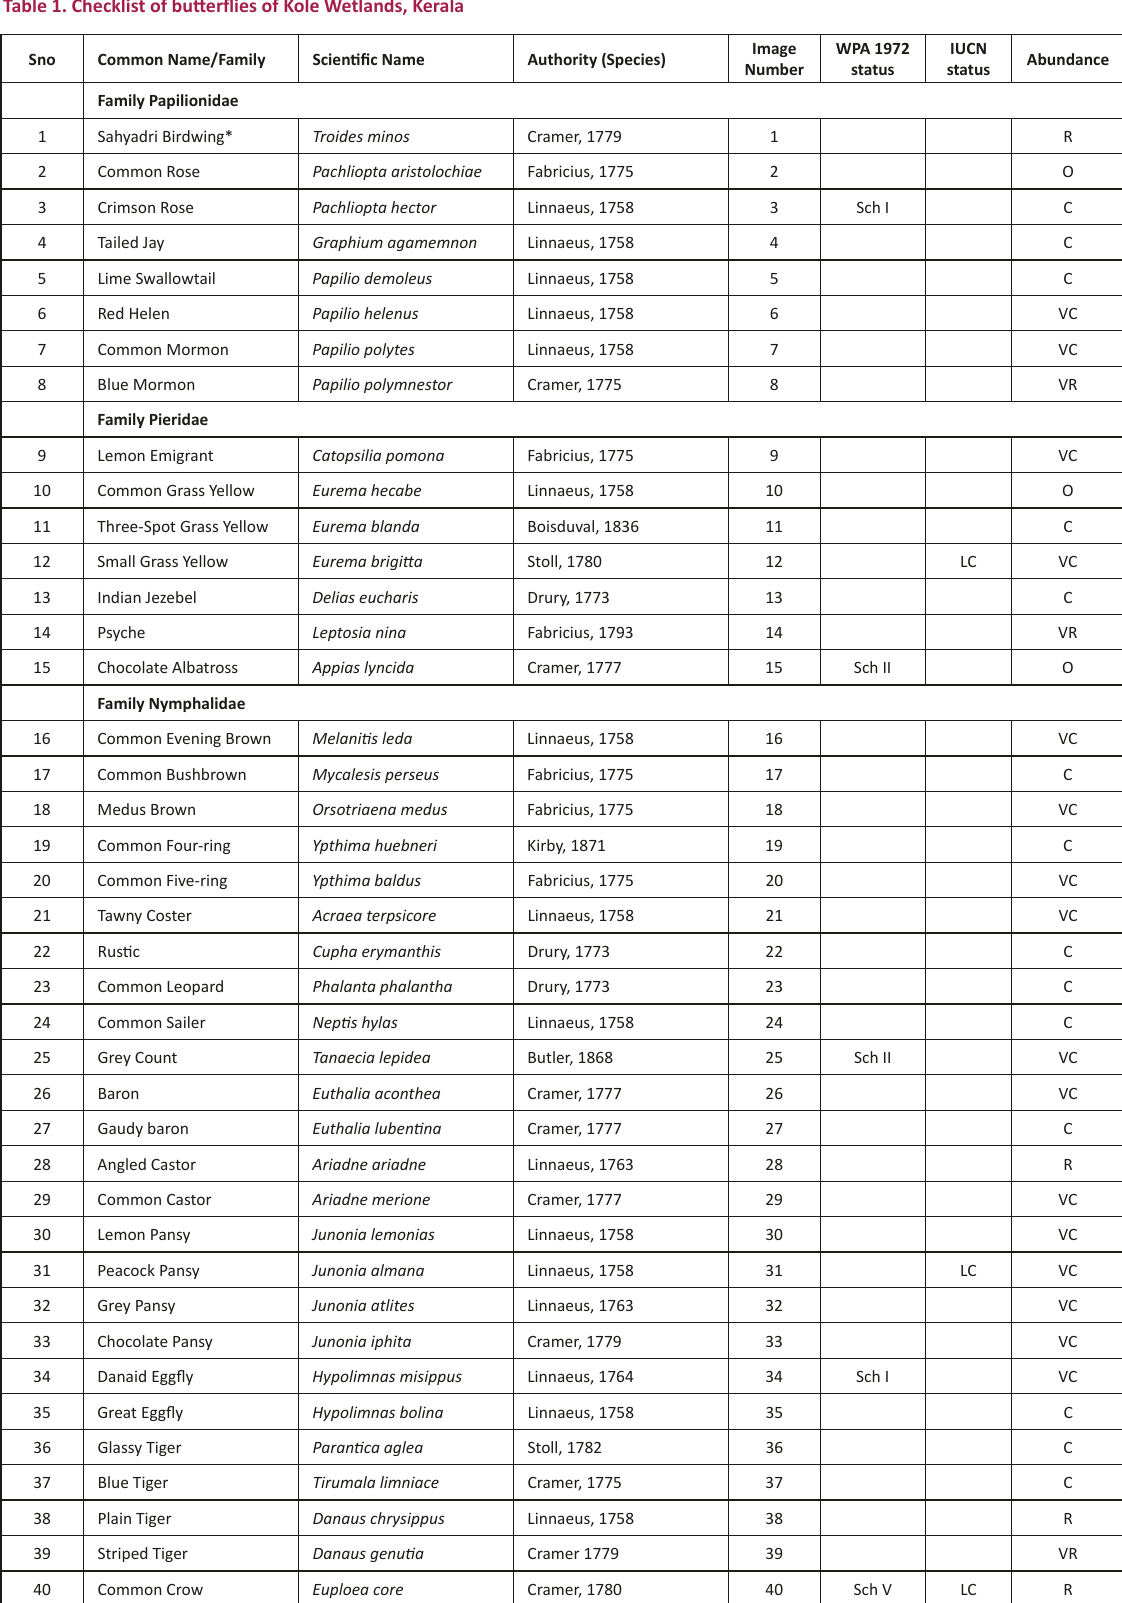
Table 1. Checklist of butterflies of Kole Wetlands,